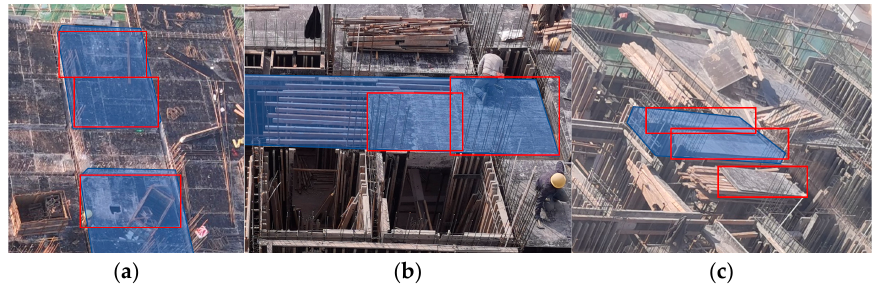
Figure 11. Registration error cases: ( a ) The interference of messy lines after rain; ( b ) Incomplete formwork; ( c ) Difficult distinction between stacked formwork and bottom formwork.